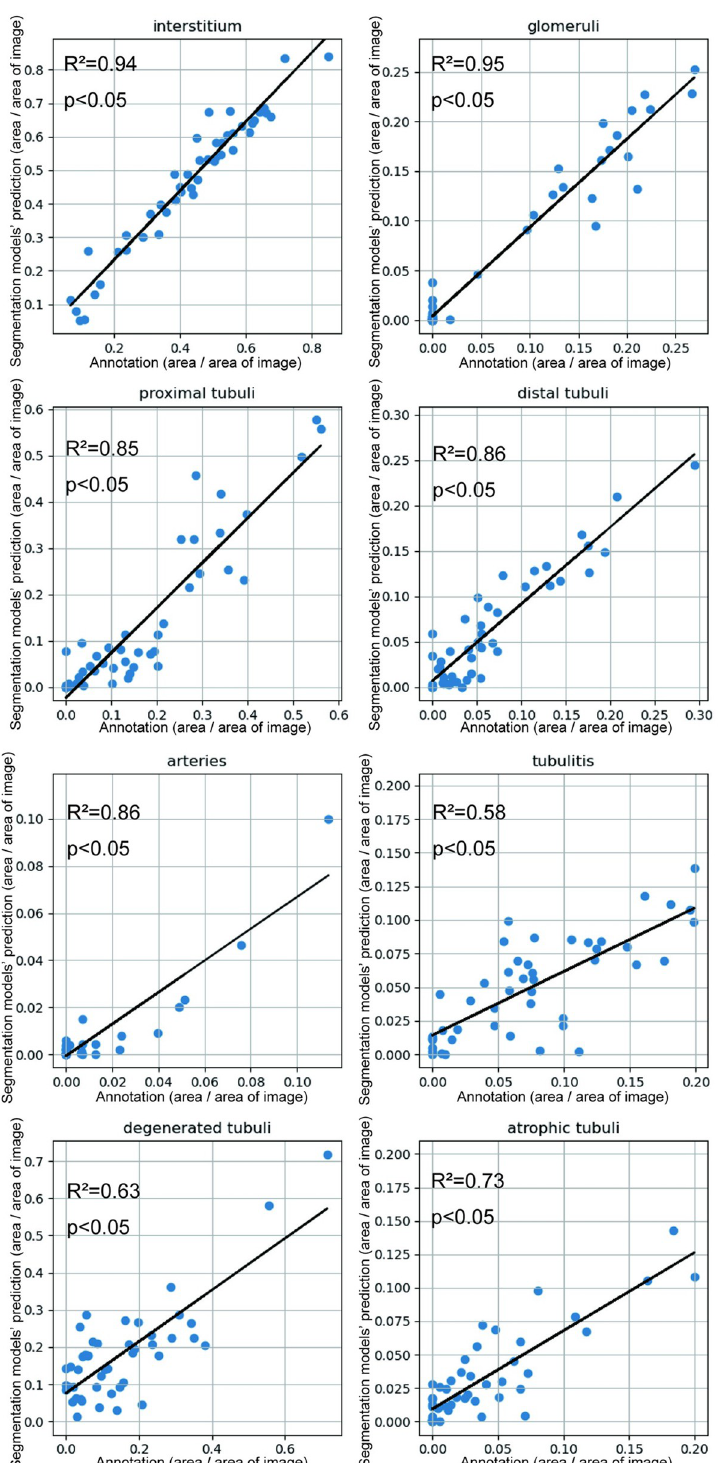
Fig 3. Correlation of areas between annotations and segmentation model predictions. There were high correlations in the interstitium, glomeruli, proximal tubules, and distal tubules. Tubulitis, degenerated tubules, atrophied tubules, and arteries were moderately correlated between annotations and segmentation model